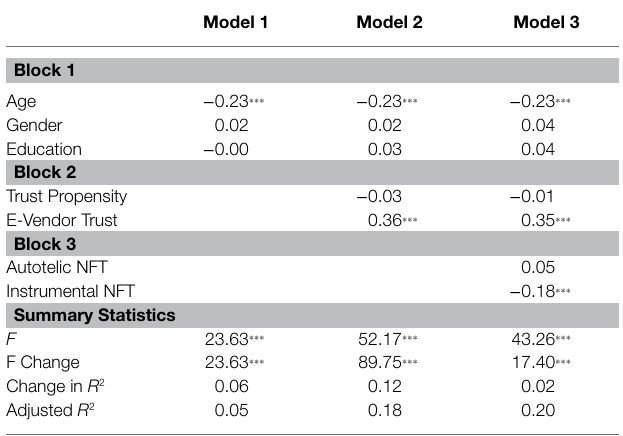
TABLE 3 | Results of the hierarchical regression models predicting willingness to purchase online.